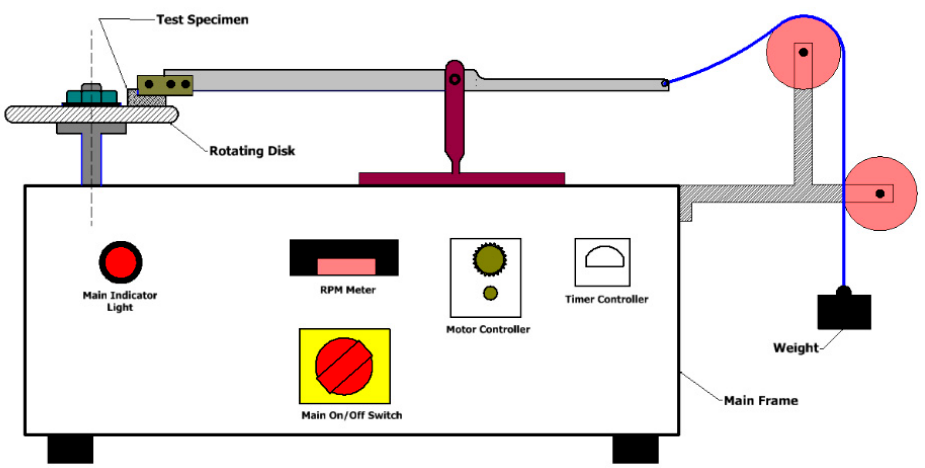
Figure 4. Pin-on-disc Figure 4. Pin ‐ on ‐ disc machine.